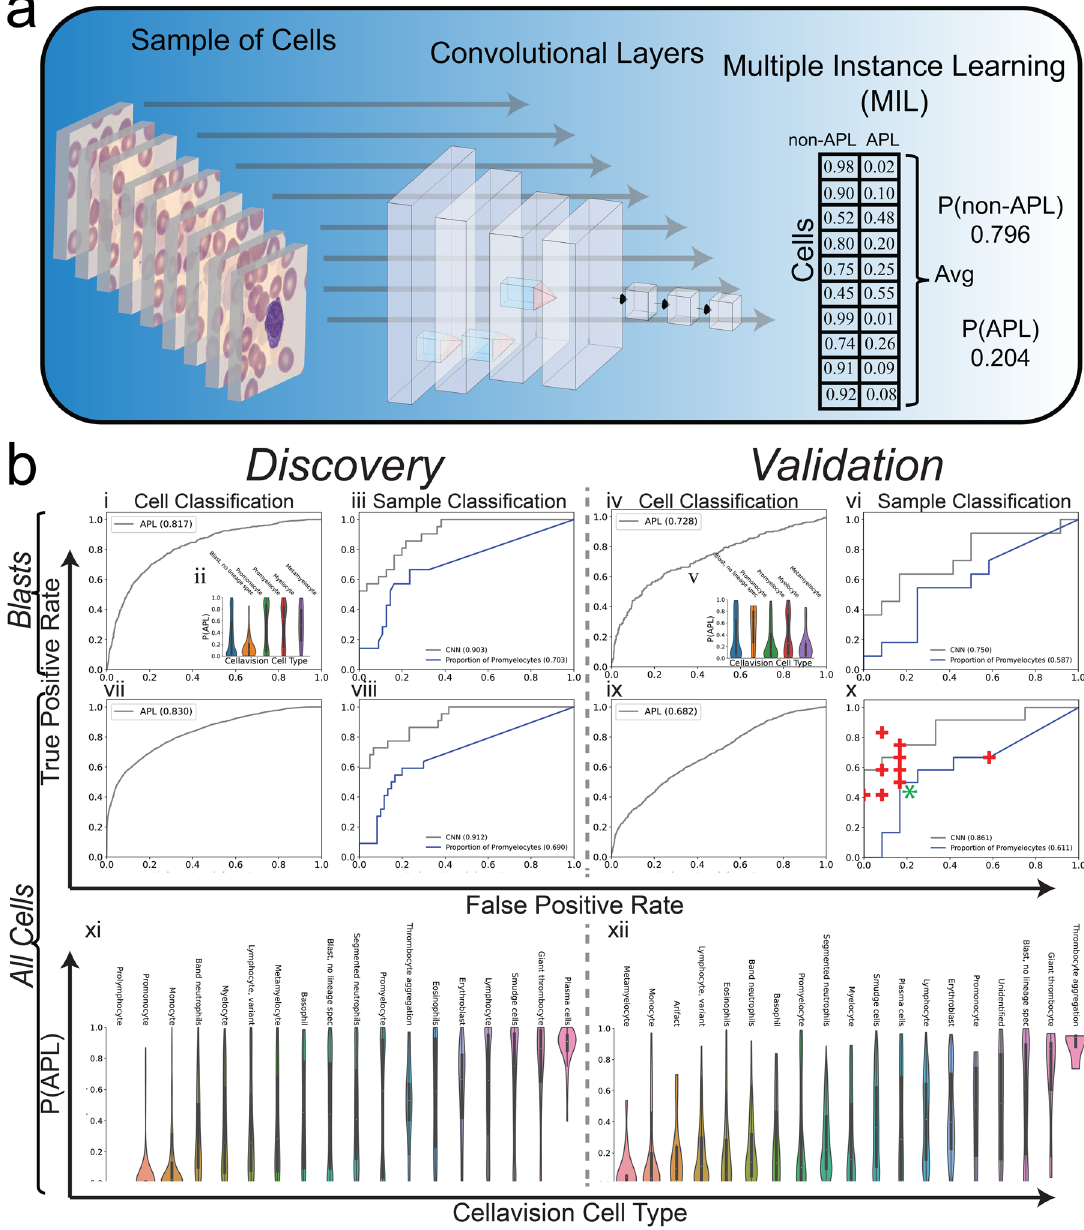
Fig. 2 Sample classi fi cation via multiple-instance learning approach. a A deep learning architecture was designed to train sample-level classi fi cation of collections of white blood cells from peripheral smears. The proposed model takes a collection of cells from a given sample/ individual and applies the same convolutional and fully connected layers described in Fig. 1 to arrive at per-cell predictions for APL/AML. The per-cell predictions are then averaged over all the cells to arrive at a sample-level prediction. b The proposed model was trained where CellaVision data was available on a discovery cohort of 82 patients and tested on an independent prospective validation cohort of 24 patients for which performance metrics are shown. Initially, the model was trained only on immature myeloid cells, here denoted as Blasts, and performance was assessed both at the cell (i,iv) and sample/patient (iii,vi) level for the discovery and validation cohort where cell-level predictions come from cell assignment layer within network and sample/patient predictions come from aggregation layer within the network. Performance was assessed in the discovery cohort in Monte – Carlo (MC) cross-validation and was assessed in the validation cohort by applying the 100 MC models trained in discovery onto the validation cohort in ensemble. Probability of a cell being APL is shown per CellaVision cell type (ii,v). Sample-level performance from the MIL model was benchmarked against the proportion of promyelocytes within a sample (iii,vi,viii, x). In addition, the model was trained on all cell types from CellaVision, here denoted as All Cells, and performance was assessed both at the cell (vii,ix) and sample/patient (viii,x) level for the discovery and validation cohort. CellaVision cells from patients in the validation cohort were provided to 10 clinicians to assess clinician diagnostic speci fi city/sensitivity against deep learning model (x) ( + denotes an individual clinician. * denotes two individuals with the same performance). Probability of being APL is shown for all CellaVision cell types in the discovery (xi) and validation (xii)